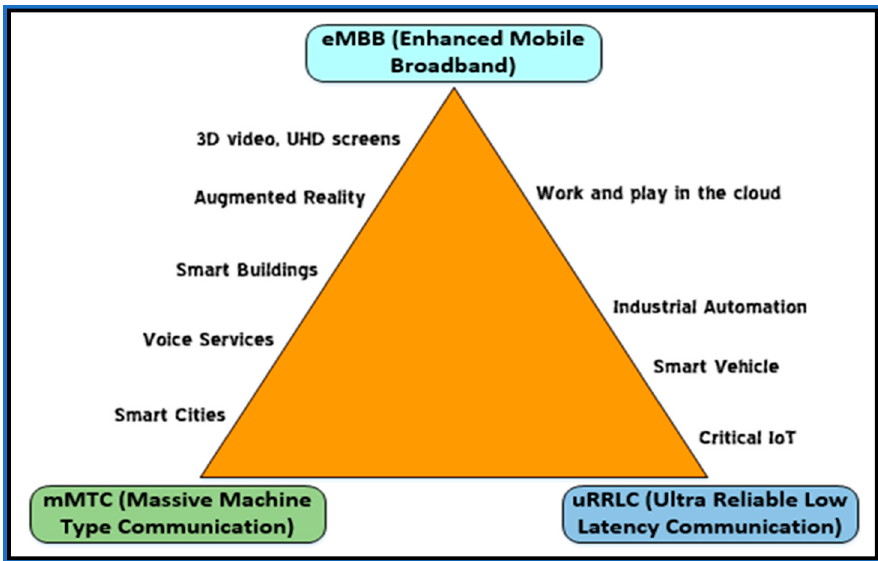
Figure 1. Usage scenario of IMT for 5G.